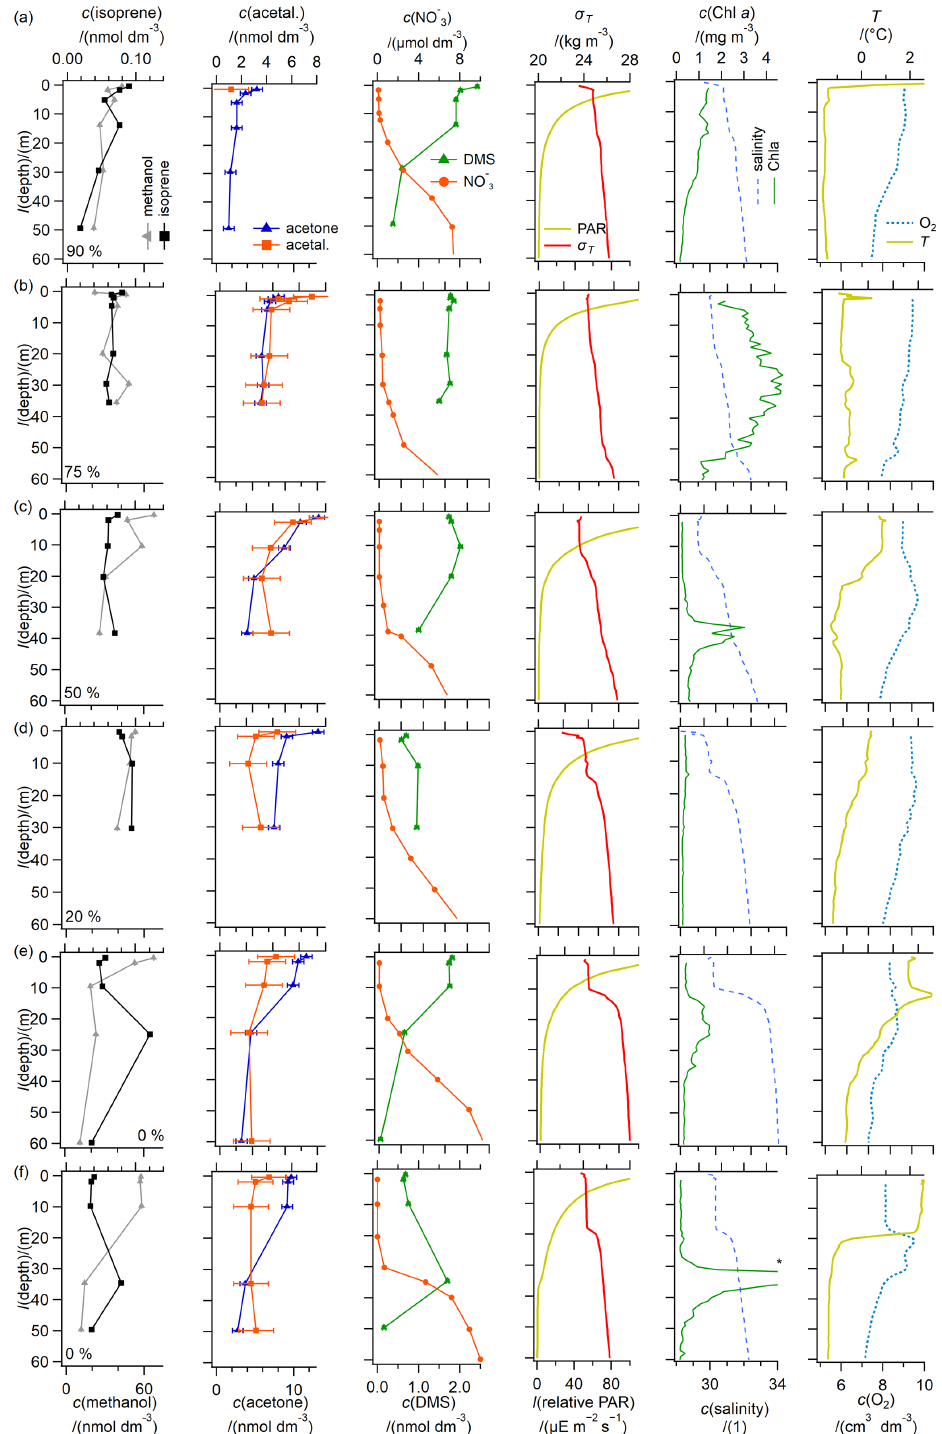
Figure 7. Depth profile concentrations arranged by decreasing SIC. Geographical locations of the stations in panels (a) to (f) are indicated in Fig. 1. SIC at the time of sampling was (a) 90%, (b) 75%, (c) 50%, ( (d) 20%, (e) 0%, and (f) 0%, where 0% indicates ice free at the time of sampling (acetal. is short for acetaldehyde; temp. is short for temperature); ∗ Chl a increases up to 13mgdm − 3 at the Chl a maximum (Amundsen Science Data Collection, 2017). Error bars show measurement noise. Limited measurements of acetaldehyde during the early part of the cruise are due to contamination from the CTD, and the single measurement came from the handheld Niskin bottle (30cm depth).